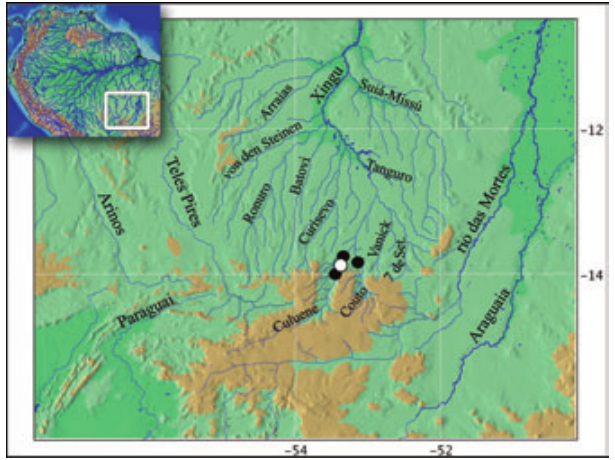
Fig. 5. Distribution of Hypostomus kuarup . White symbol represents type